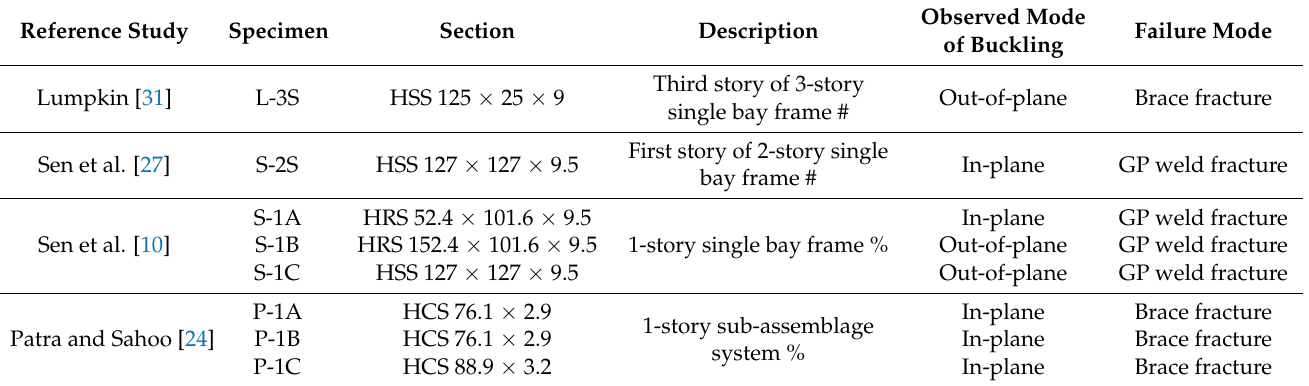
Table 1. Summary and modes of buckling observed in the past experimental studies on IPB braced